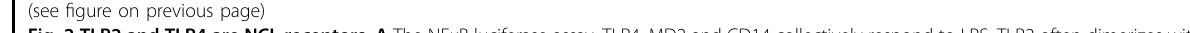
alarmin-inactive NCL-HA mutants (Fig. 3A, F). NCL